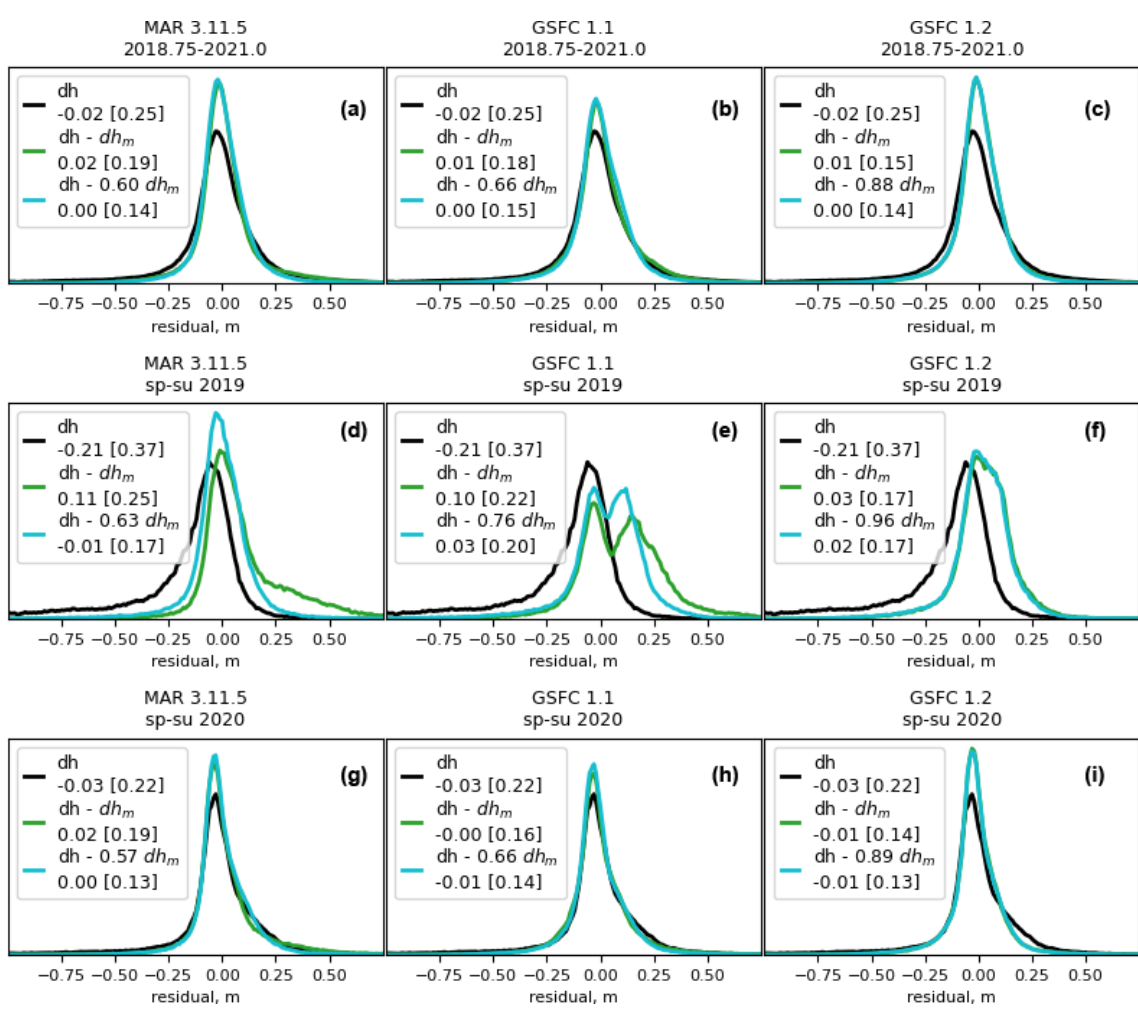
Figure 5. Height-difference and residual histograms for the whole ice sheet, for three time periods. The curves in each plot represent measured height change (black, dh ), height change corrected by the total model (green, d h − d h m ), and height change corrected by the model scaled by [ A ] (blue, dh − [ A ] d h m ). Vertical axis units are arbitrary, but the areas under the curves within each plot are the same. Plots in the top row (a–c) show measured and model-residual distributions for all epochs together (Q3 2018–Q4 2020). Plots in the middle row (d–f) show distributions for spring–summer for 2019 (Q1–Q2 and Q2–Q3). Plots in the bottom row (g–i) show corresponding distributions for 2020. In the legends to each histogram, dh indicates the measured height differences, and dh m indicates the modelled height changes. The second row of each legend gives the mean and [standard deviation] of the distribution in each